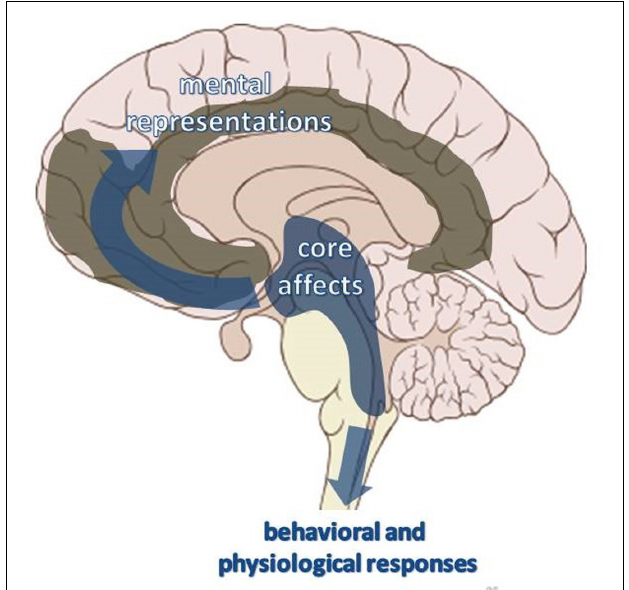
FIGURE 4 | Schematic illustration of the ascending and the descending ways where core affective neurodynamic states originating within SCMS are